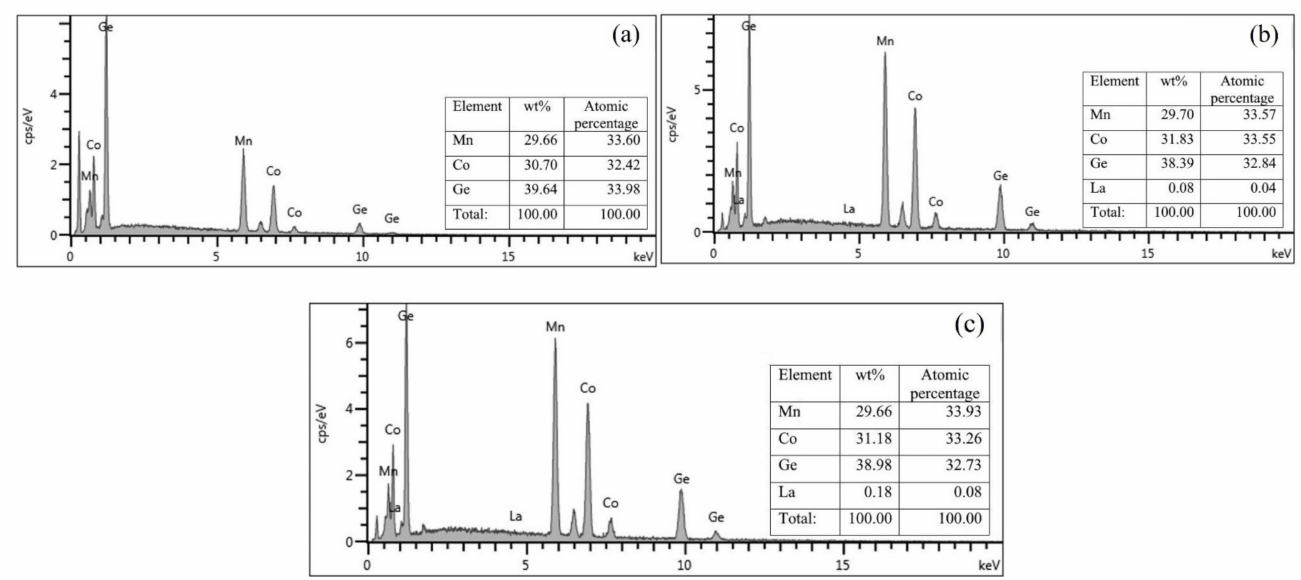
Figure 2. The EDS patterns of MnCoGe 1 − x La x alloy: ( a ) MnCoGe; ( b ) MnCoGe 0.99 La 0.01 ; ( c ) MnCoGe 0.97 La 0.03